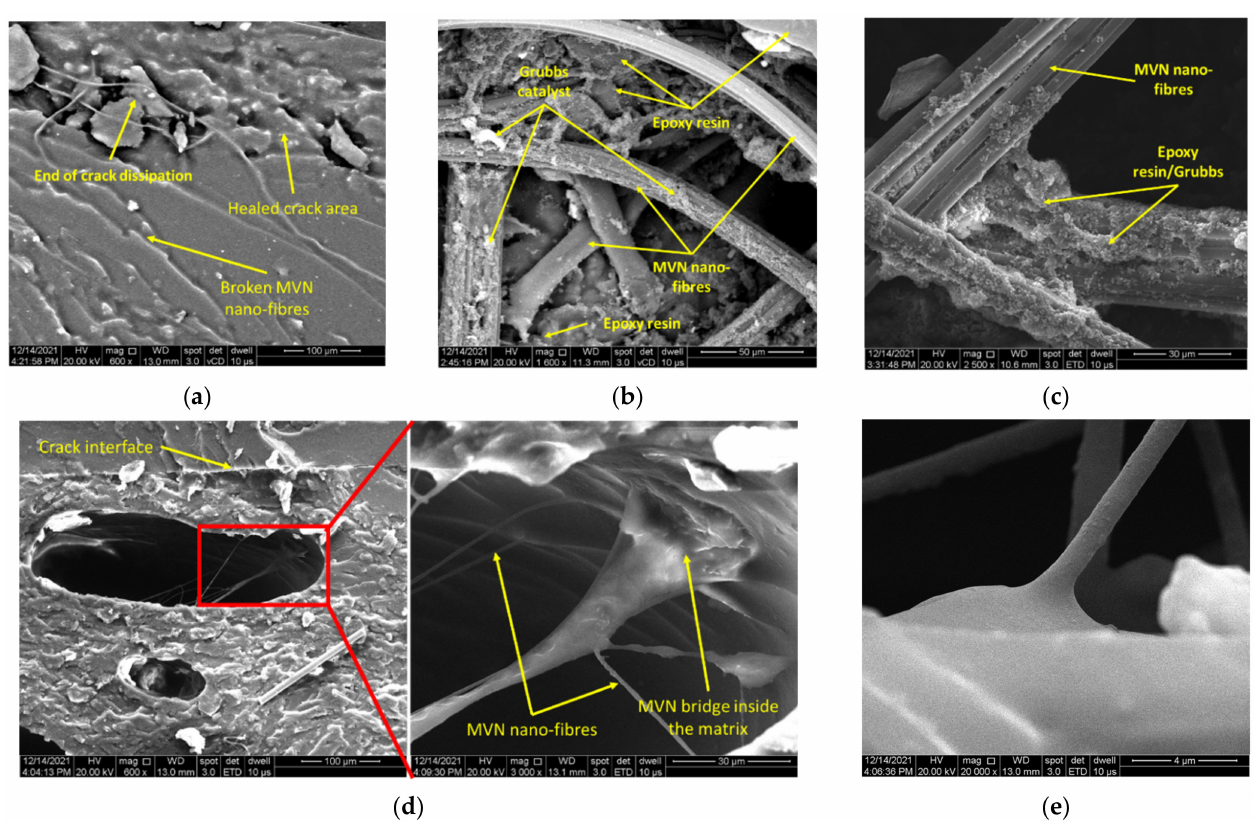
Figure 12. SEM analysis of the tested epoxy/MVN specimens, illustrating ( a ) crack bridging, ( b , c ) MVN nano-fibres bundles, ( d ) crack interface and nano-fibres bridge formation in the ma- trix, and ( e ) detailed view of a